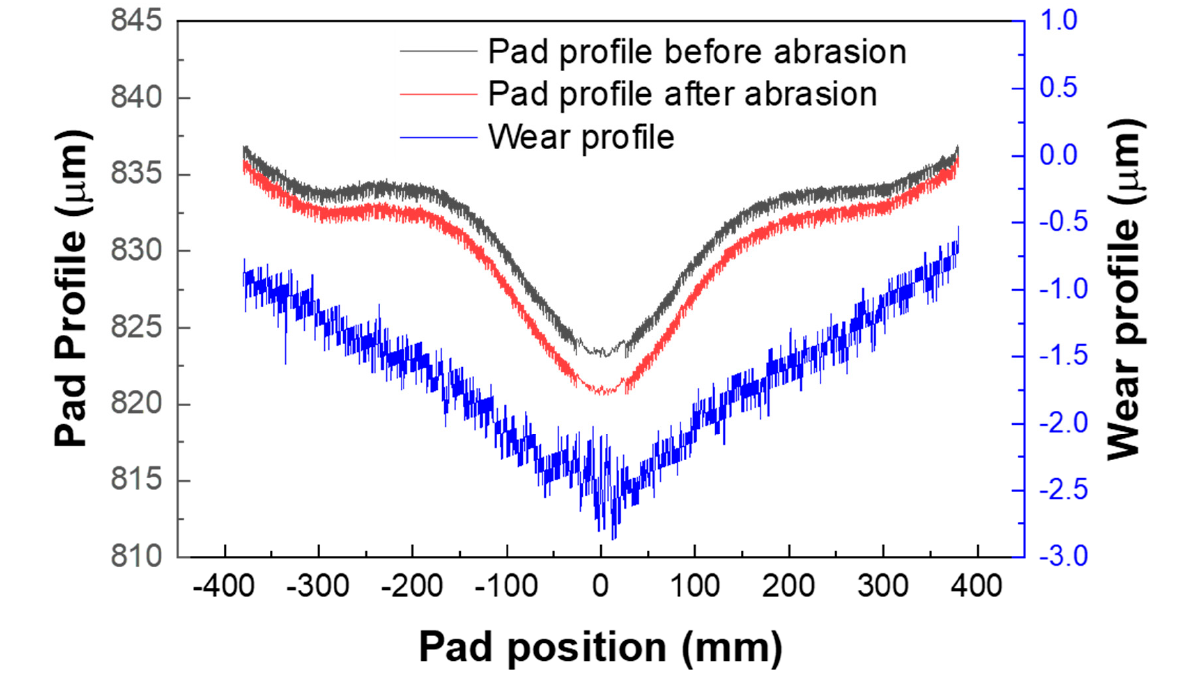
Figure 2. A typical pad profile (center fast) before and after abrasion, and a wear profile. Table 1. Relative occupancy time (ROT, %) of the profile cases; even, linear center fast, linear edge fast, and controlled.